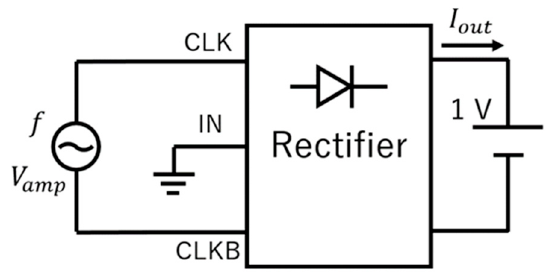
Figure 4. Schematic for SPICE simulation.